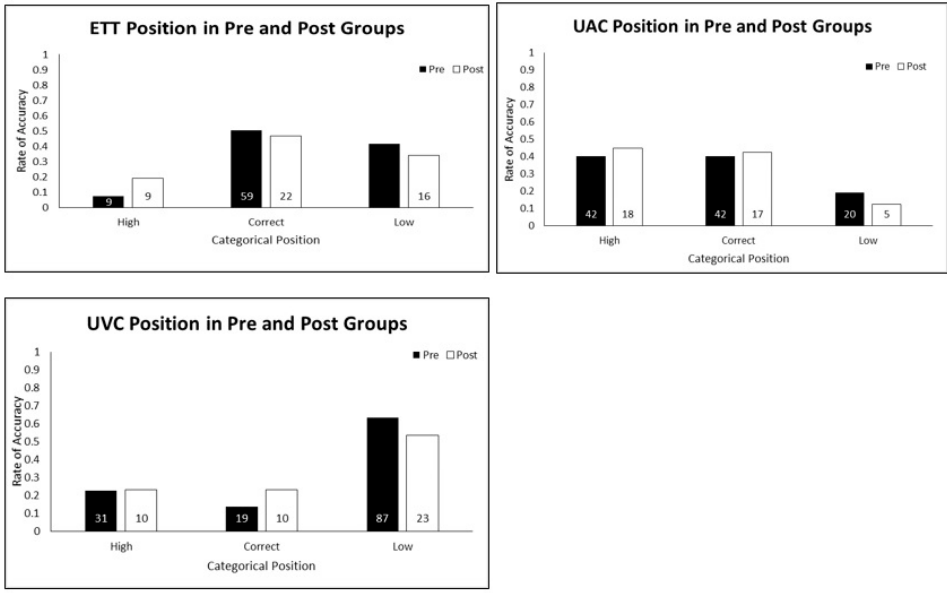
Figure 2. Accuracy of initial position for ETT, UAC and UVC in pre and post groups.